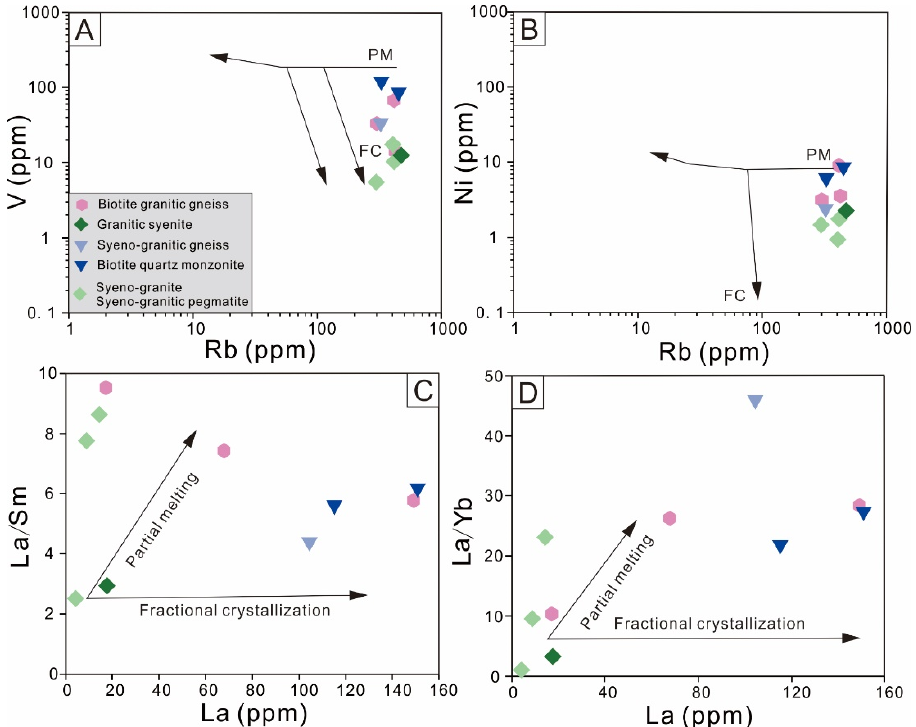
Figure 10. Compositional variation diagrams of ( A , B ) Ni, V vs. Rb diagrams of AMC basement rocks showing fractional crystallization After [53]. ( C ) La versus La/Sm and ( D ) La versus (La/Yb) N for the AMC basement rocks showing partial melting and fractional crystallization, after [54].